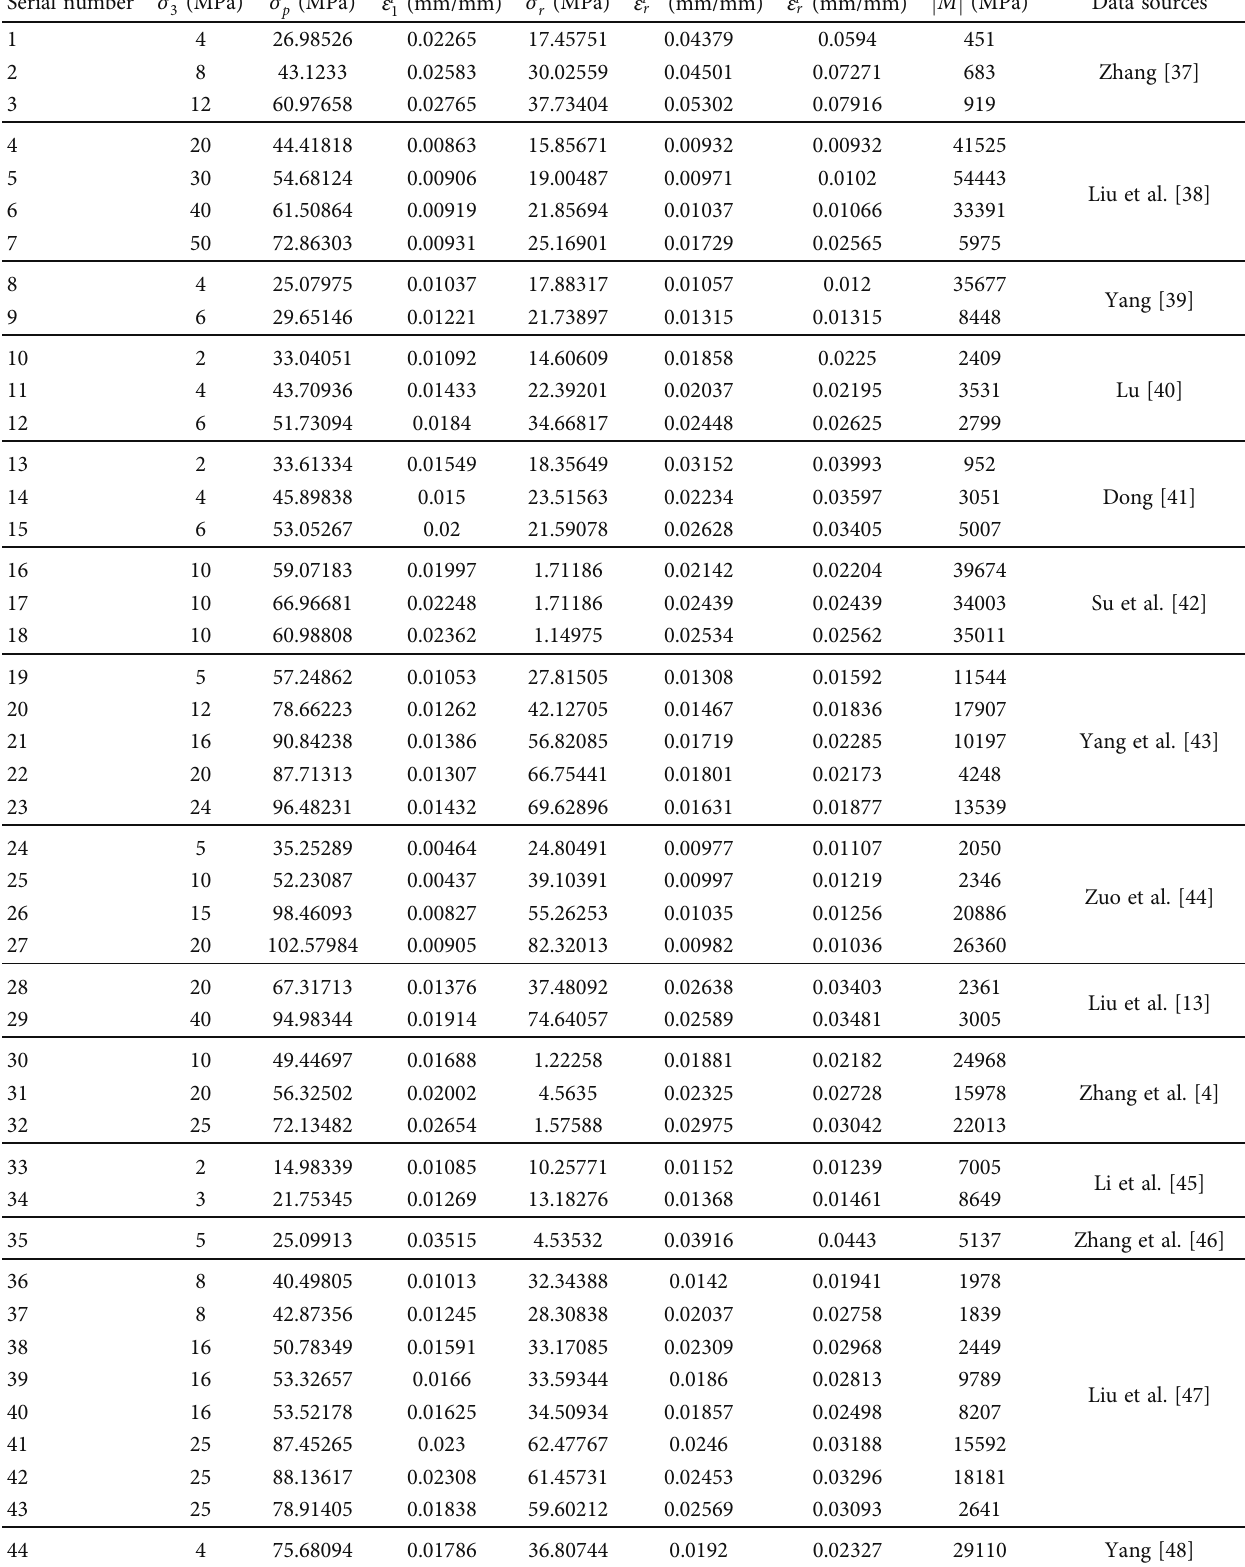
Table 1: Mechanical parameter statistics of complete stress-strain curves of raw coal during the triaxial compression. Serial number σ 3